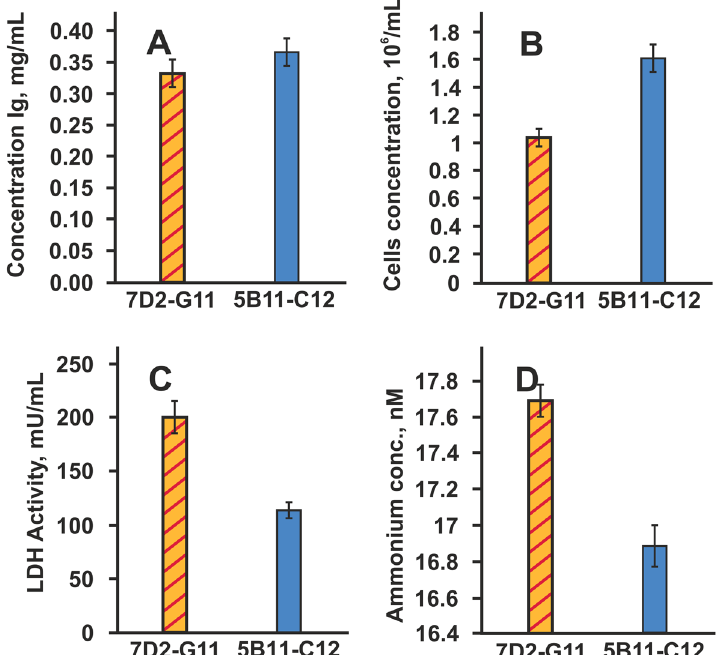
Fig. 4 Selection of subclones for developing stable cell lines by IgG production, cell concentration, and metabolic selection. IgG productivity was determined by ELISA. Level of lactate production and ammonia concentration for selected subclones 5B11/C12 and 7D2/G11was determined by